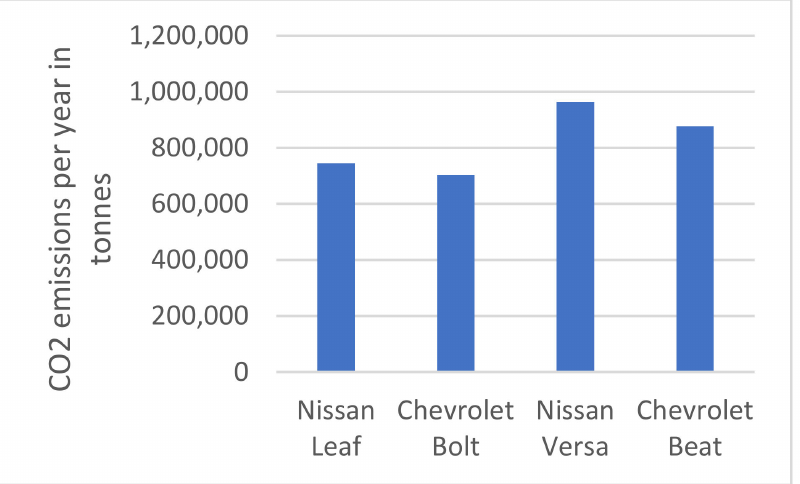
Figure 15. Annual emissions from the different vehicles used for public